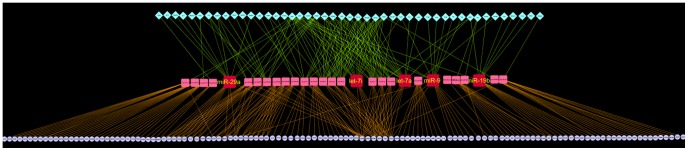
Tripartite regulatory network for Group 1 miRs.This network represents the molecular cross talk between TFs, miRs and mRNAs in PD. Square nodes in the middle layer represent miRs, diamond nodes in the upper layer representing validated TFs of respective miRs and circular nodes in the lower most layer represent mRNA targets of the miRs. Here regulation goes down from TFs to miRs and then miRs to mRNAs. TFs regulate the transcription of miRs whereas miRs regulate the translation process of target mRNAs. miRs with highest intermediate regulatory measure were denoted as IR hubs. The 5 IR hub miRs in the middle layer have been enlarged for proper visualization. 29 already known PD related miRs, associated with the top 20 most significant GO Biological Processes, were used to build this network. This network was constructed in Cytoscape interface [26].